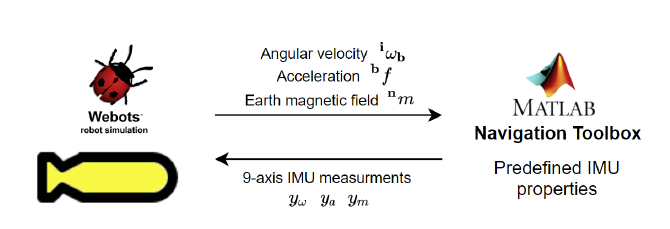
Figure 9. Angular velocity, acceleration, and local magnetic field of the earth are generated as ground truth readings at each time instant of each IMU that is modelled in an underwater environment in Webots simulator. Given the ground truth readings and the IMU properties, a realistic nine-axis IMU is modelled on MATLAB Navigation